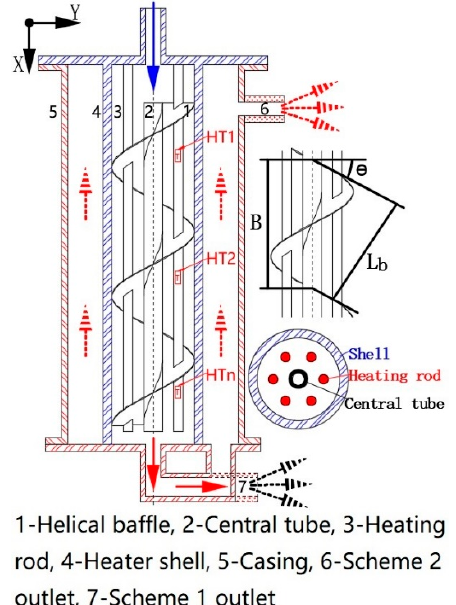
Figure 2. Schematic diagram of the tested device.